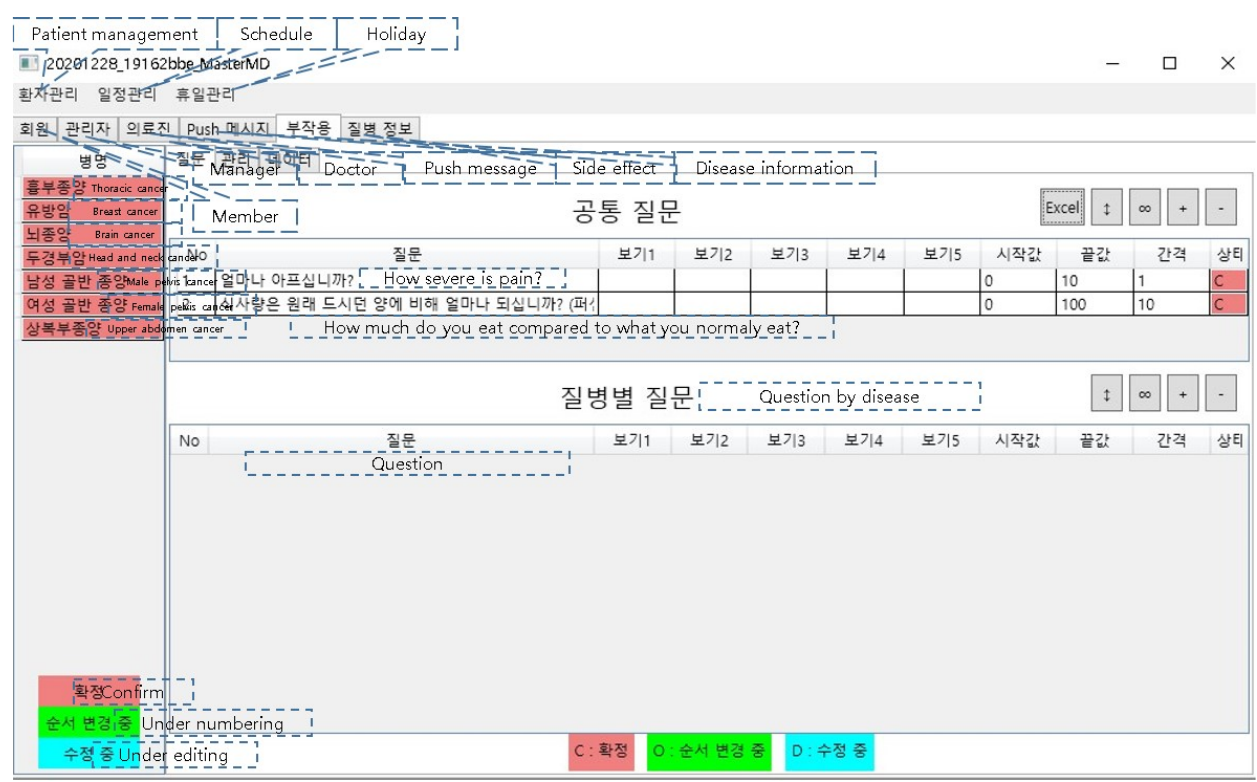
Figure 4. Start window screen of the manager program.